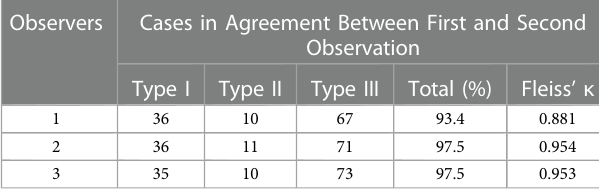
TABLE 7 Intra-observer reliability of the XX classi fi